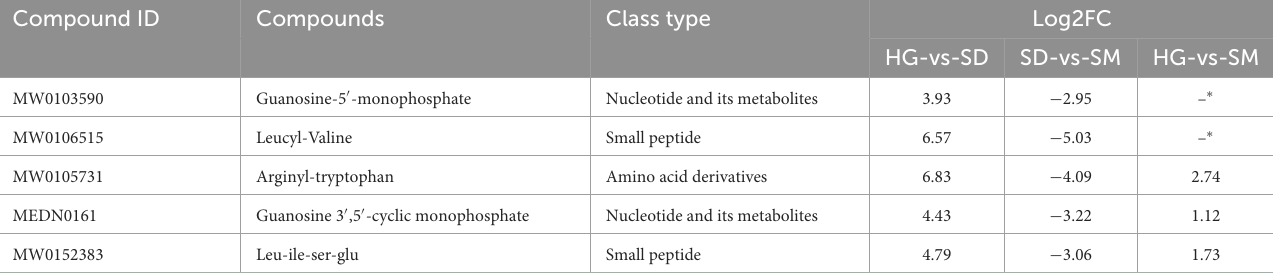
TABLE 1 Five significant DAMs commonly existing in the two or three compared